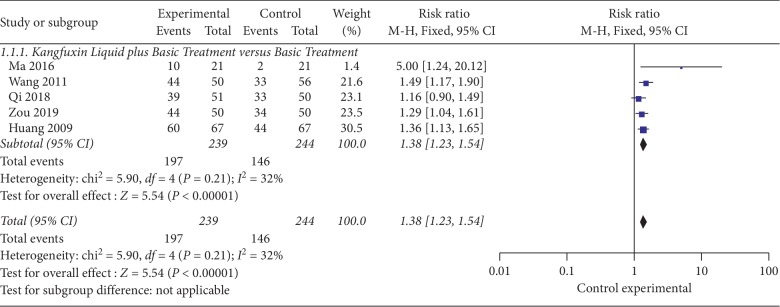
The total effective rate of KFXL combined with basic treatment versus basic treatment.